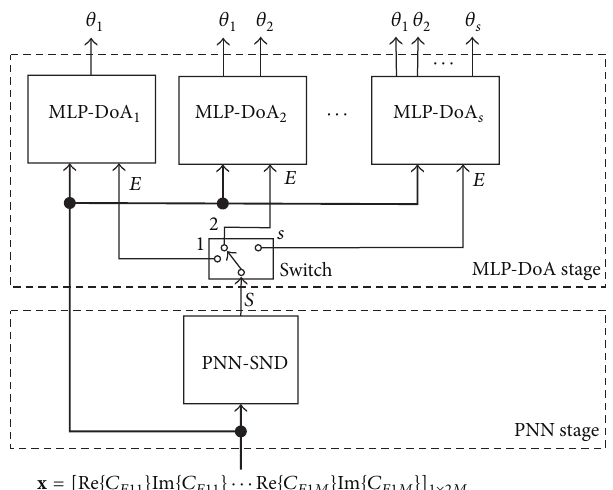
Figure 2: Architecture of PNN-MLP neural model for DoA estima- tion of signals of the stochastic EM sources in azimuth